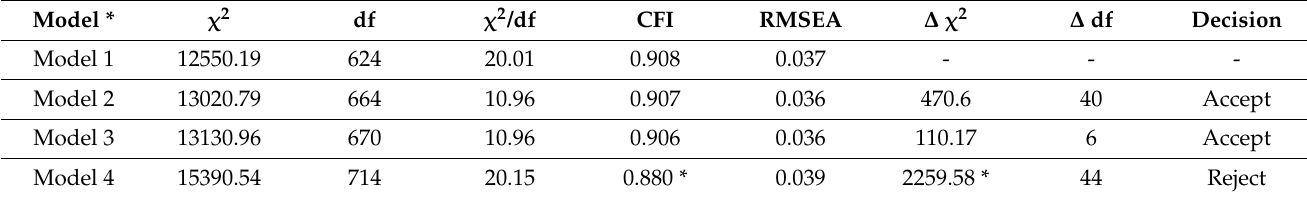
Table 3. Goodness-of-fit statistics for tests of invariance across young ( n = 251), middle ( n = 250), and